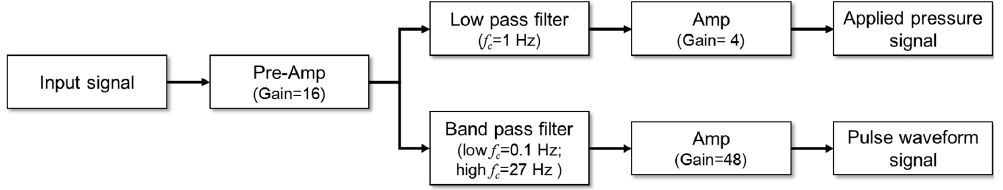
Figure 7. Flow chart of data acquisition of applied pressure and pulse waveform.